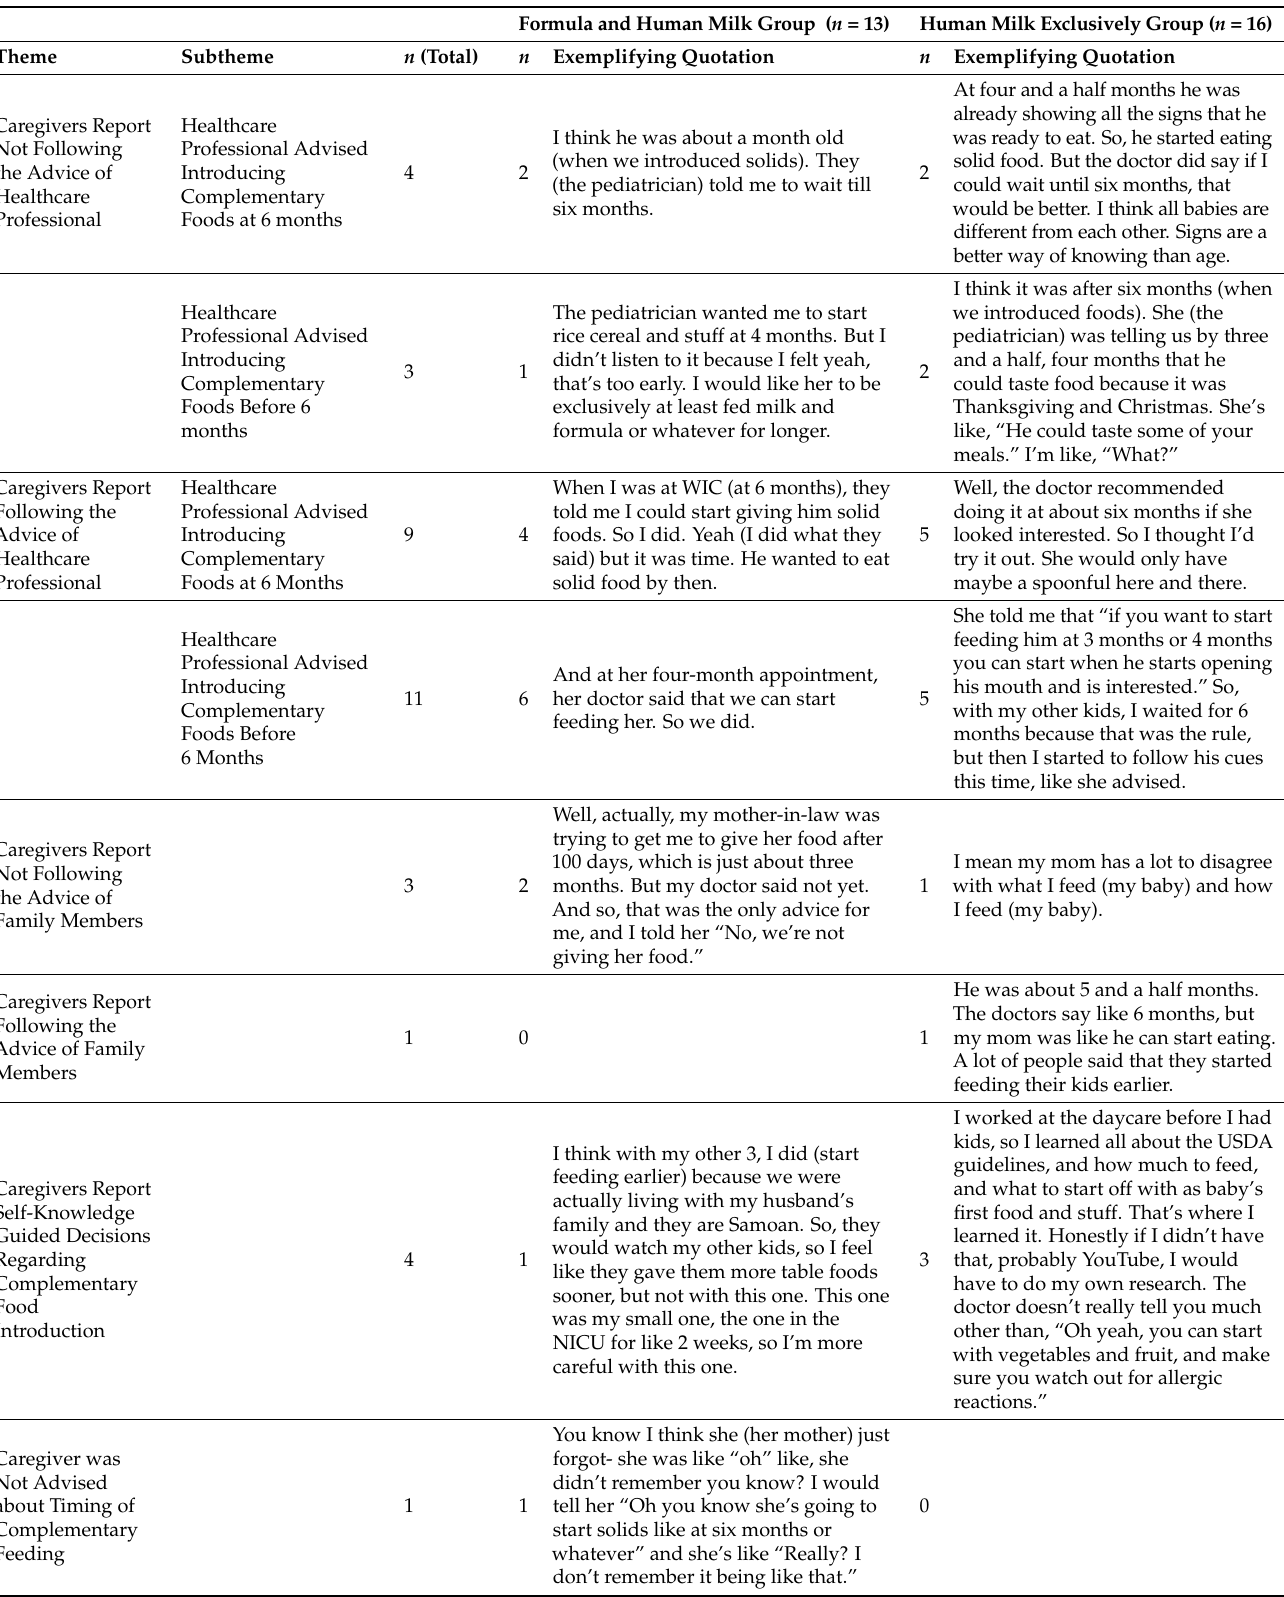
Table 3. Themes and subthemes related to Principal Sources of Advice for the Timing of the Introduc- tion of Complementary Foods, with exemplifying quotes taken verbatim from in-depth interviews with Native Hawaiian and Other Pacific Islander, and Filipino caregivers, n =